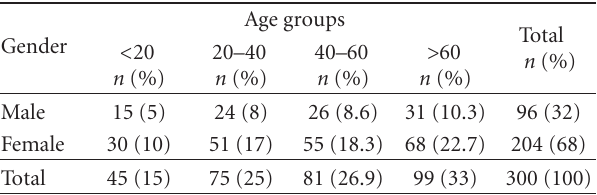
Table 3: Age and gender distribution in hospital-acquired UTI